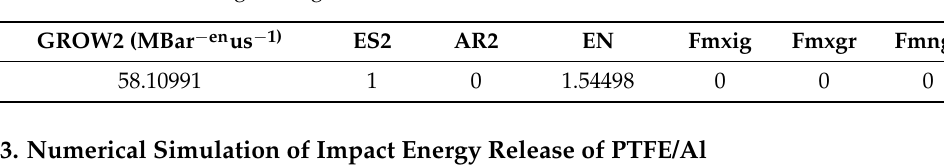
Table 7. Parameters of ignition growth model for